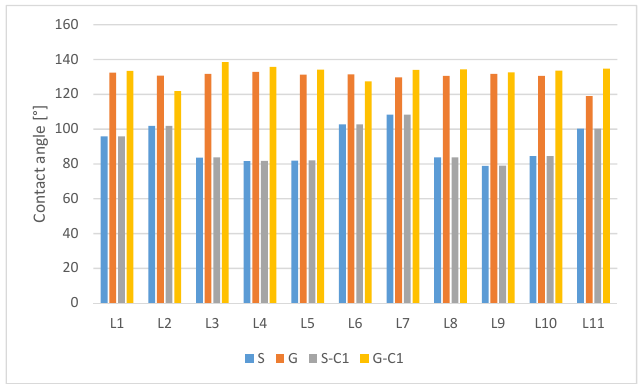
Figure 11. Contact angles for samples after laser texturing (S—smooth non-modified sample, S-C1 —smooth, chemically modified sample, G—geometrised, non-modified sample, G-C1 geometrised, chemically modified sample).